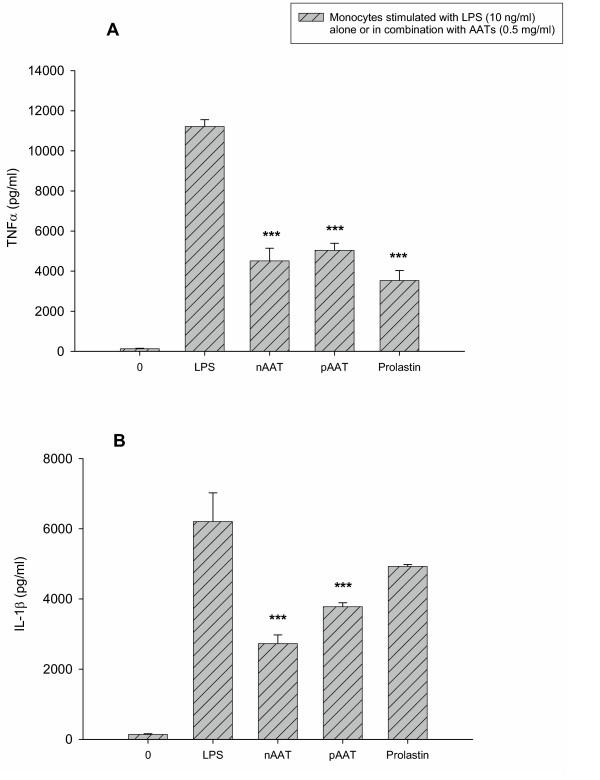
Comparisons of the effects of native (nAAT), polymeric (pAAT) and Prolastin on lipopolysaccharide – stimulated TNFα (A) and IL-β (B) production by human blood monocytes isolated from four healthy donors. Isolated blood monocytes were treated with LPS (10 ng/ml) alone or together with 0.5 mg/ml nAAT, pAAT or Prolastin for 18 h. TNFα and IL-1β levels were measured by ELISA. Each bar represent the mean ± S.E. *** p < 0.001.